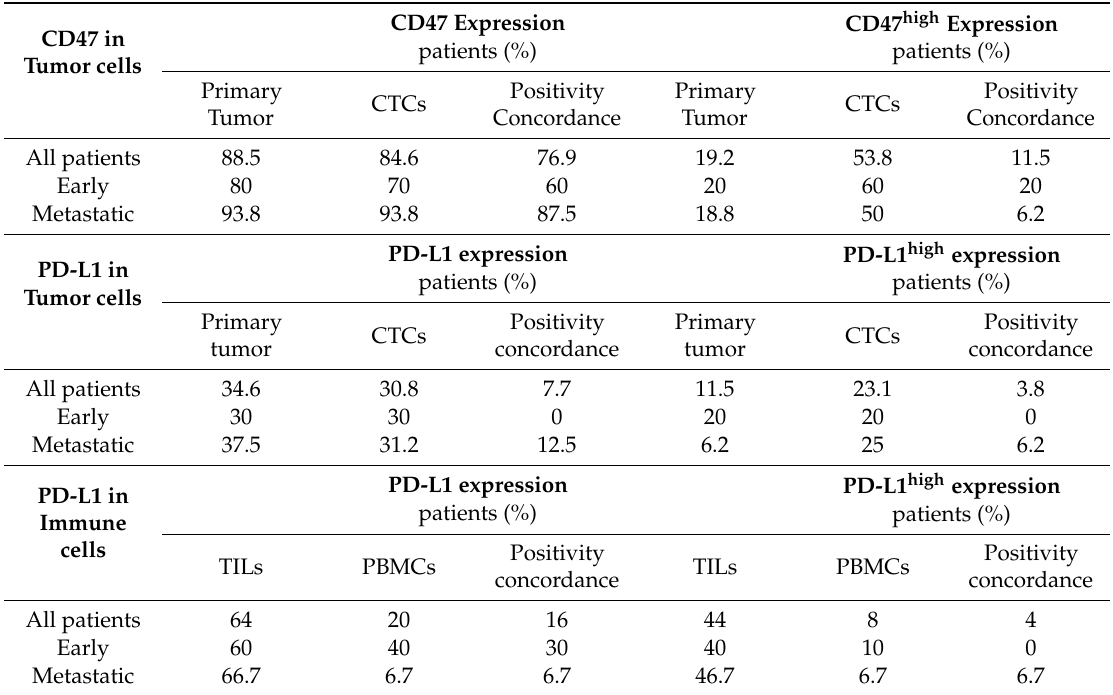
Table 6. Comparative analysis of CD47 and PD-L1 expression among the primary tumor tissue and peripheral